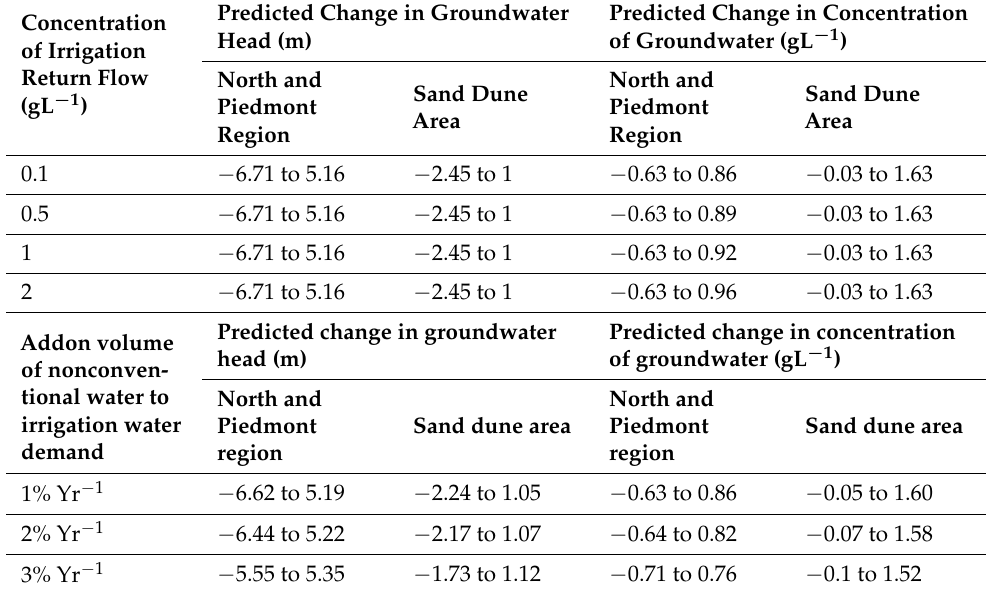
Table 5. Impact of irrigation return flow concentration and an additional contribution of nonconven- tional